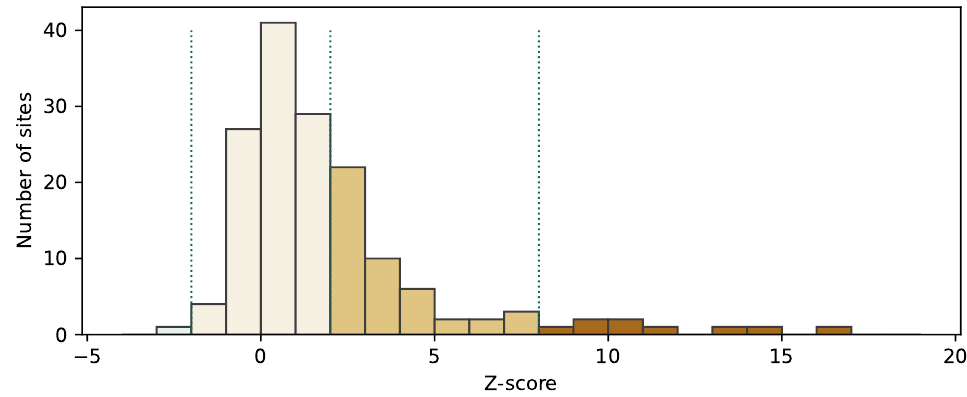
Figure 5. Z-score distribution of the downtown sites with the activity level thresholds of during the spontaneous